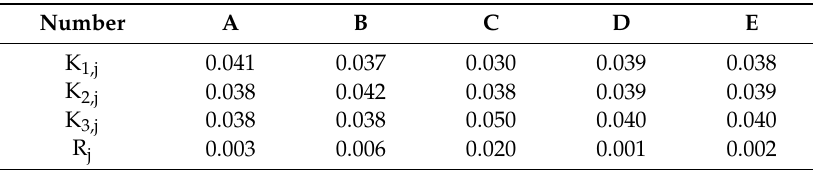
Table 17. Range analysis of expansibility test